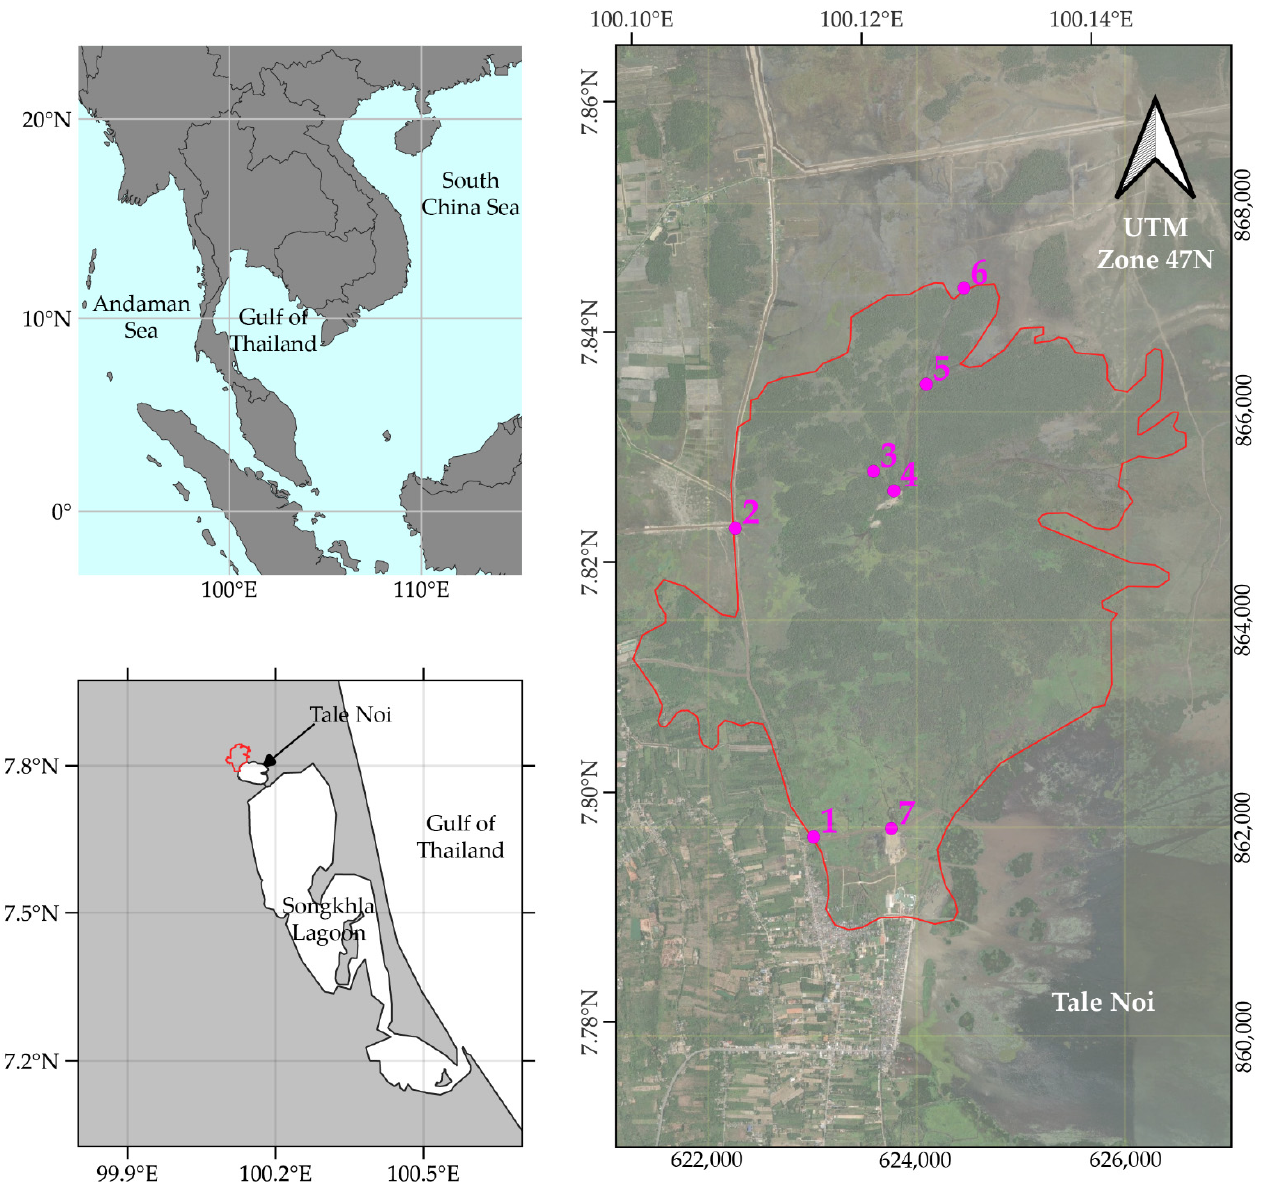
Figure 1. Map of the study area and the location of the sampling site. (Noted: the numbers represented samping stations